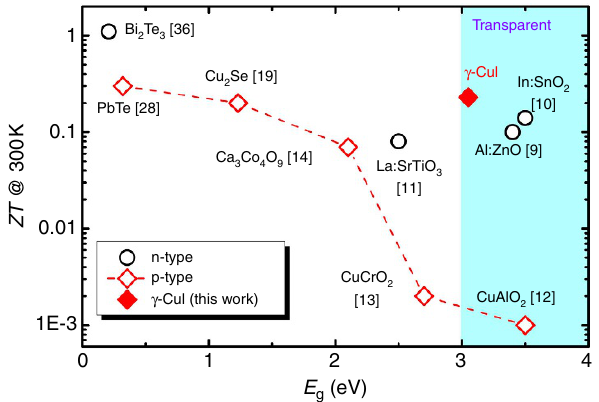
Figure 4 | Figure of merit versus energy bandgap. Comparing the thermoelectric ZT of typical n- and p-type thermoelectric materials and g -CuI thin films (this work) at room temperature. Dashed line is guide to the eyes. Detailed data see Supplementary Table